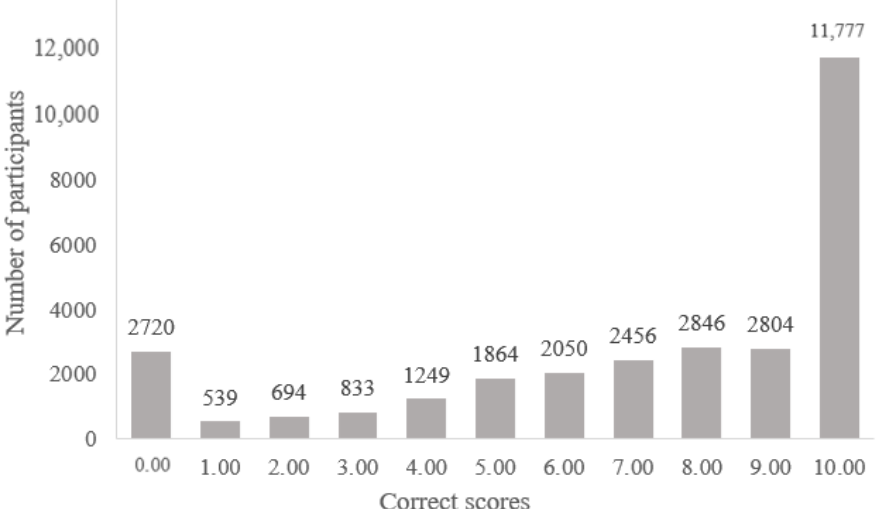
Figure 1. Scores for knowledge about warning signs of cardio-cerebrovascular diseases.